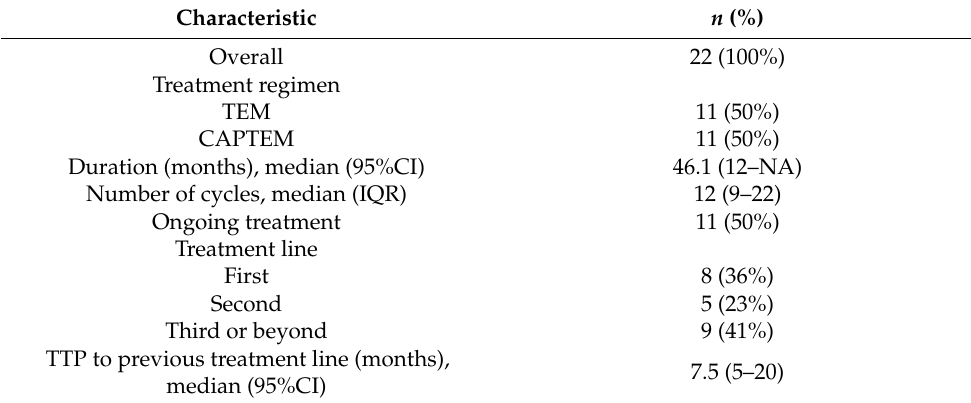
Table 3. Treatment